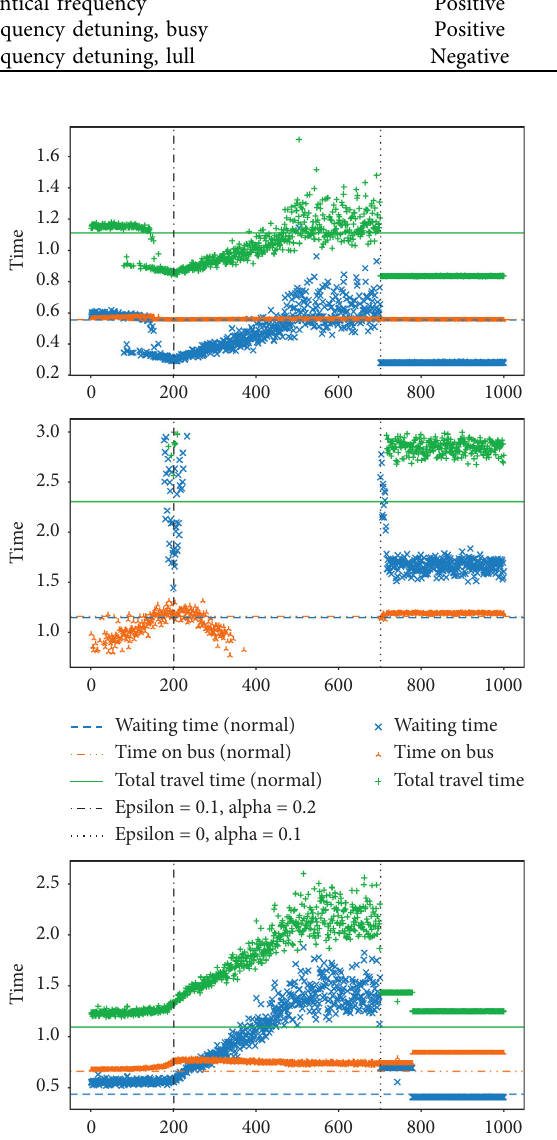
Figure 9: N � 2 buses serving M � 12 bus stops in a loop, where a bus takes an action at a bus stop when nobody wants to alight. Top: identical natural frequency, middle: frequency detuning during the busy period, and bottom: frequency detuning during the lull pe- riod. All three graphs share the same